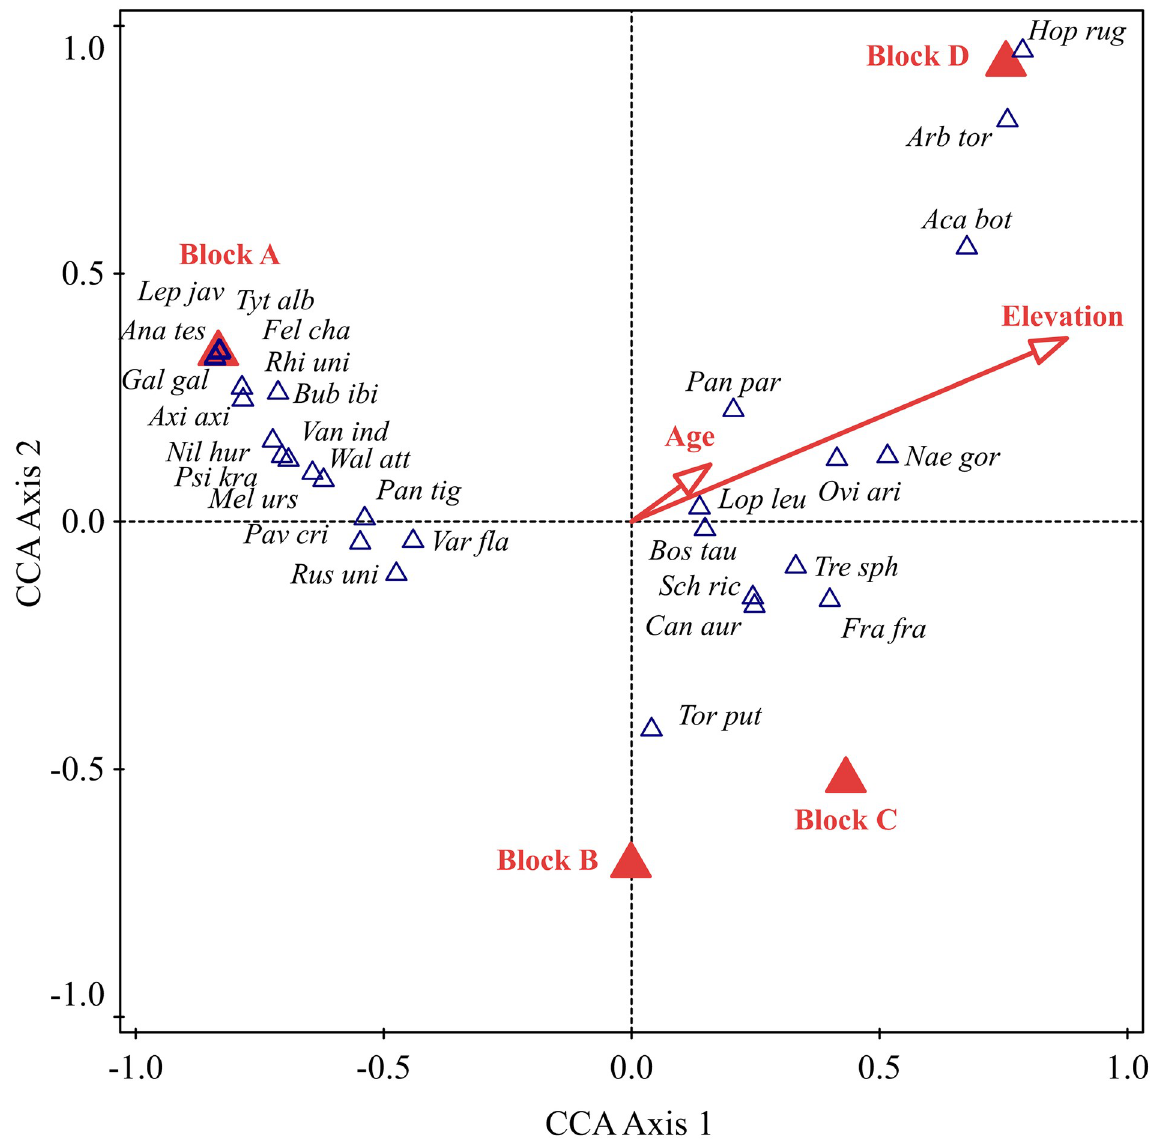
Fig 3. The relationship between the different animal species used for medicine and different environmental factors. The 1 st canonical axis explained 16.98% and the 2 nd 4.19% of the total variation in the data. Abbreviations: Aca bot- Acanthocobitis botia ; Ana tes- Anabas testudineus ; Arb tor- Arborophila torqueola ; Axi axi- Axis axis ; Bos tau- Bos taurus ; Bub ibi- Bubulcus ibis ; Can aur- Canis aureus ; Fel cha- Felis chaus ; Fra fra- Francolinus francolinus ; Gal gal- Gallus gallus ; Hop rug- Hoplobatrachus rugulosus ; Lep jav- Leptoptilos javanicus ; Lop leu- Lophura leucomelanos ; Mel urs- Melursus ursinus ; Nae gor- Naemorhedus goral ; Nil hur- Nilssonia hurum ; Ovi ari- Ovis aries ; Pan par- Panthera pardus ; Pan tig- Panthera tigris ; Pav cri- Pavo cristatus ; Psi kra- Psittacula krameri ; Rhi uni- Rhinoceros unicornis ; Rus uni- Rusa unicolor ; Sch ric- Schizothorax richardsonii ; Tor put- Tor putitora ; Tre sph- Treron sphenurus ; Tyt alb- Tyto alba ; Van ind- Vanellus indicus ; Var fla- Varanus flavescens ; Wal att- Wallago attu .